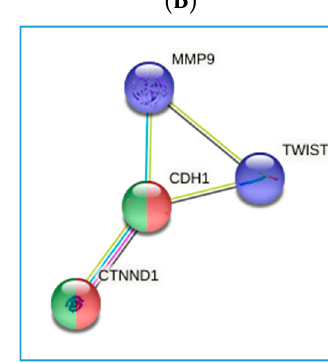
Figure 7. Polymorphism-related protein-protein interaction networks generated using STRING. Colored nodes indicated the first choice of interactors. ( A ) The network is made up of the 11 genes ( p < 0.05) reported in Table 8 for the rs9471643 SNPs. ( B ) The network is made up of the 4 genes reported in Table 7 for the pre-miRNA rs8111742 and rs121224 SNPs.